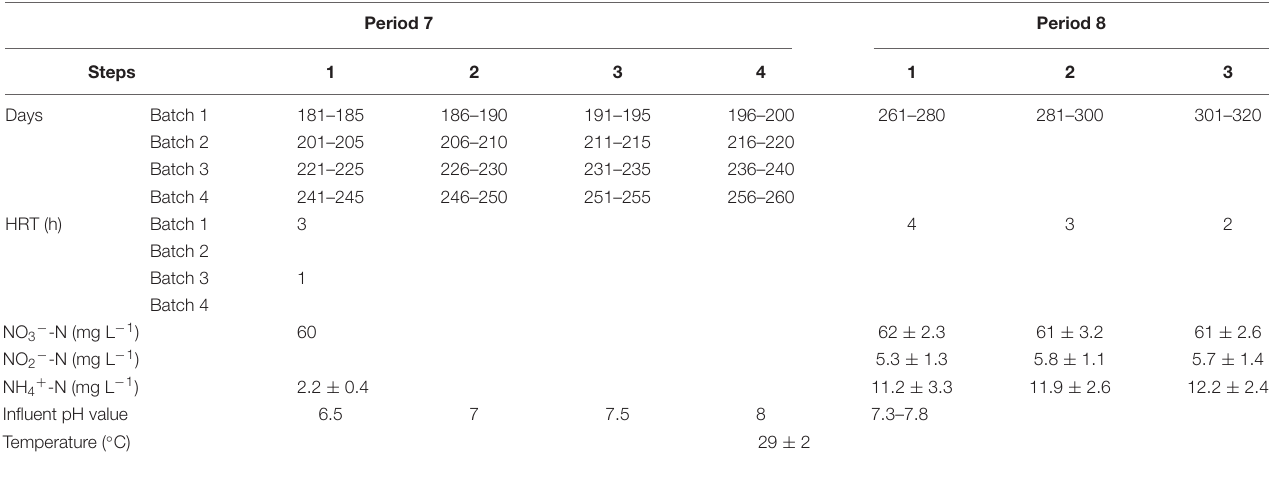
TABLE 2 | Influent conditions of the R 1 –R 4 reactors in periods 7 and